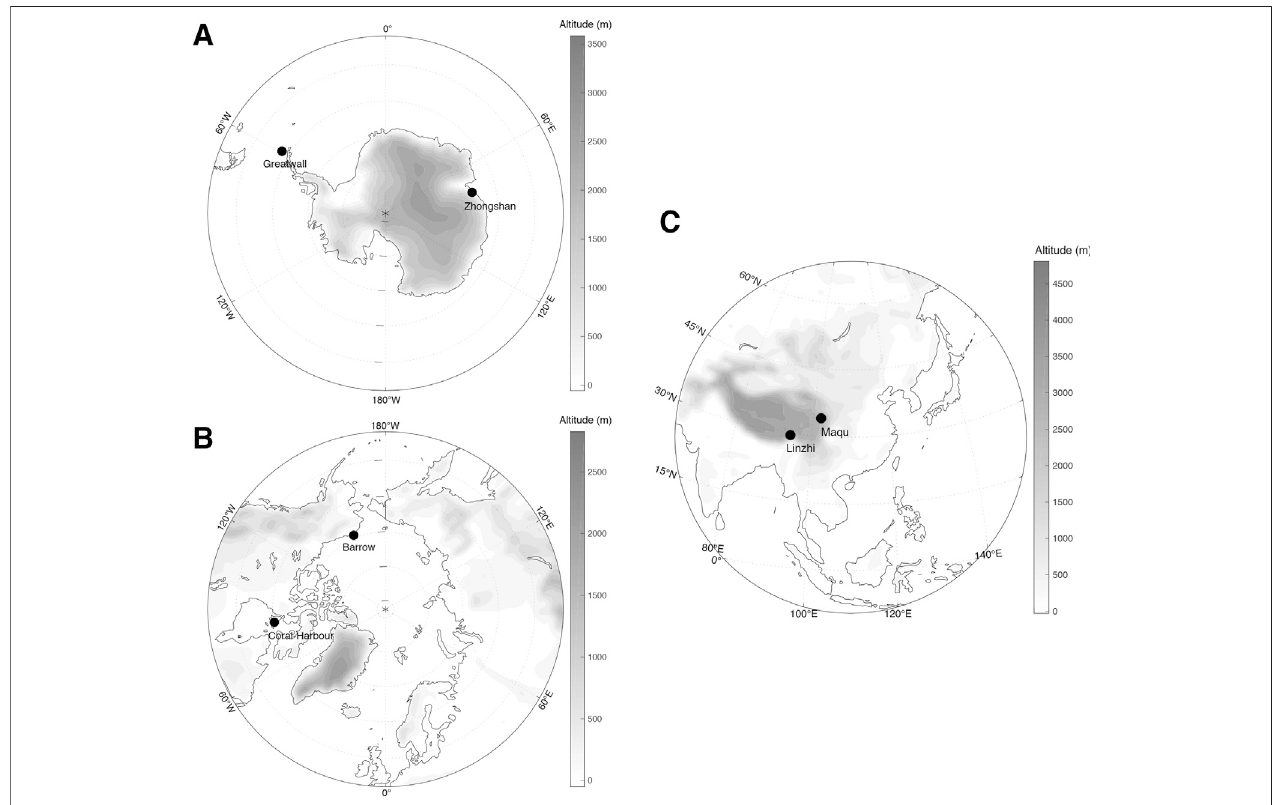
FIGURE 1 | Topographic map of the tripolar regions and the locations of the Zhongshan, Greatwall, Barrow, Coral Harbour, Linzhi and Maqu stations. (A) Antarctica part; (B) Arctic part; (C) The coordinated labels coincide (80 ° E and 0 ° ).